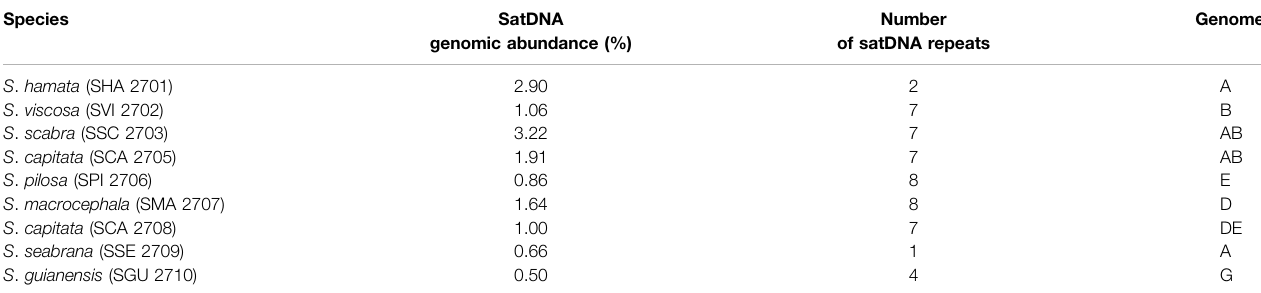
TABLE 3 | Comparison of genomic abundance (%) of satDNA repeats, by mapping all reads to consensus sequences identi fi ed by the TAREAN tool. Species SatDNA Number genomic abundance (%) of satDNA repeats